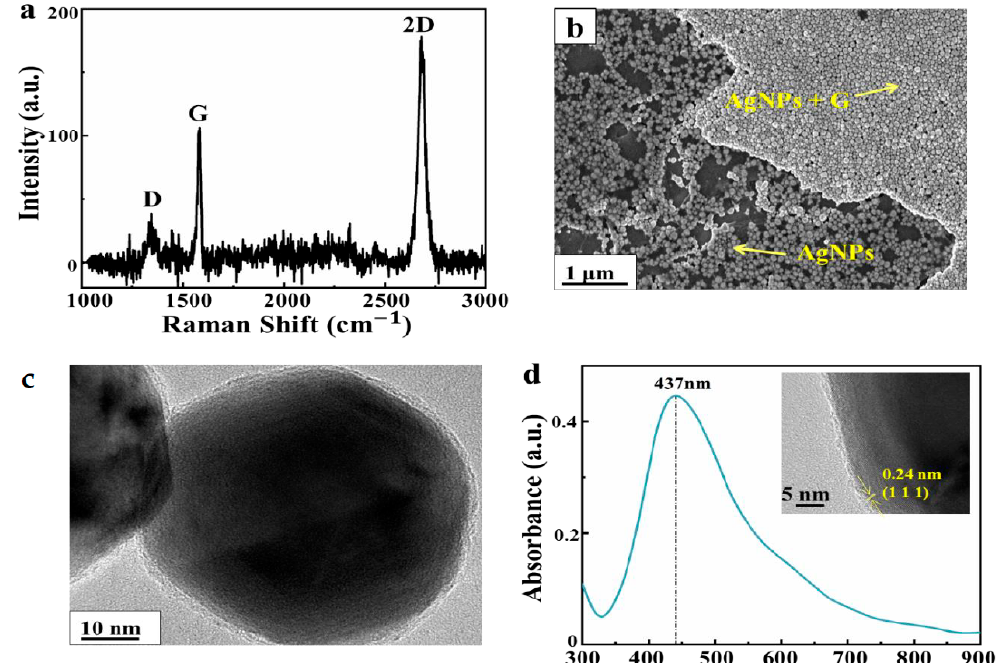
Figure 2. ( a ) Raman spectrum of single layer graphene collected from bare graphene. ( b ) SEM image of the boundary between Ag nanoparticles (AgNPs) and AgNPs supported by graphene. ( c ) TEM image of an AgNP. ( d ) UV − visible absorption spectrum of AgNPs (inset: high − magnification transmission electron microscopy (HRTEM) image of AgNPs).